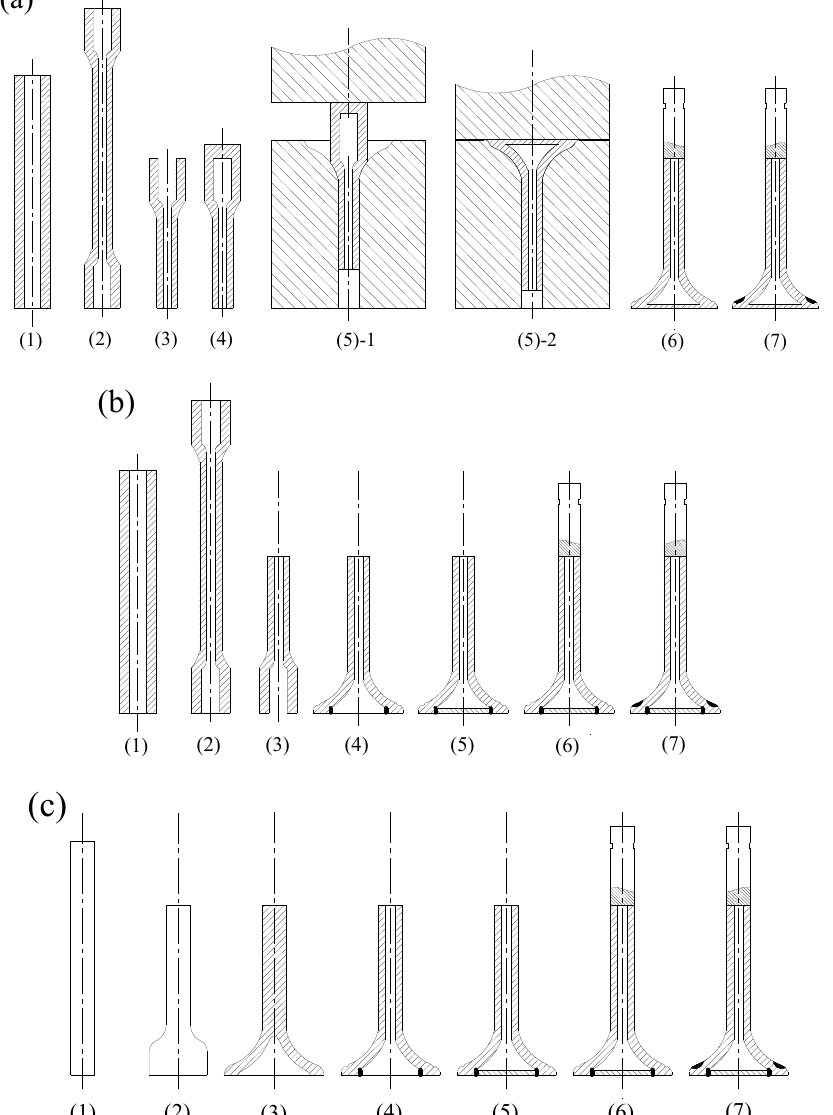
Figure 2. Three methods proposed by Huaiji Dengyun Auto-parts (Holding) CO., LTD. (HJ company): ( a ) hollow engine valve cross wedge rolling and head forging manufacturing method [12]; ( b ) hollow engine valve cross wedge rolling and friction welding manufacturing method [13]; ( c ) hollow engine valve drilling and friction welding manufacturing method